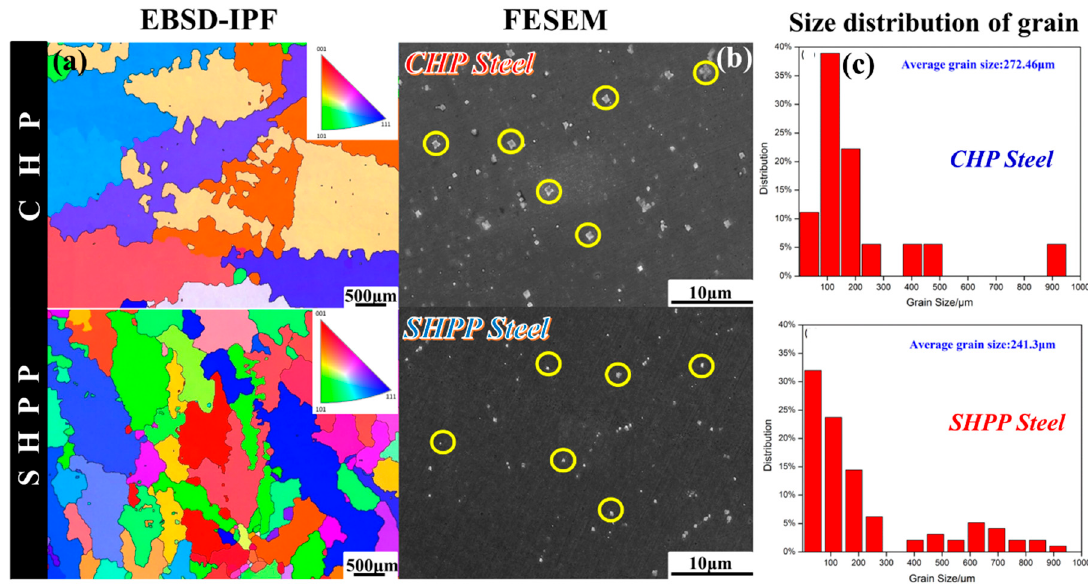
Figure 10. Grain size analysis of CHP and SHPP steel by orientation decomposition image map ( a ); FESEM micrographs of distribution and quantity of precipitates in both steels ( b ); size distribution of austenite grain in both steels ( c